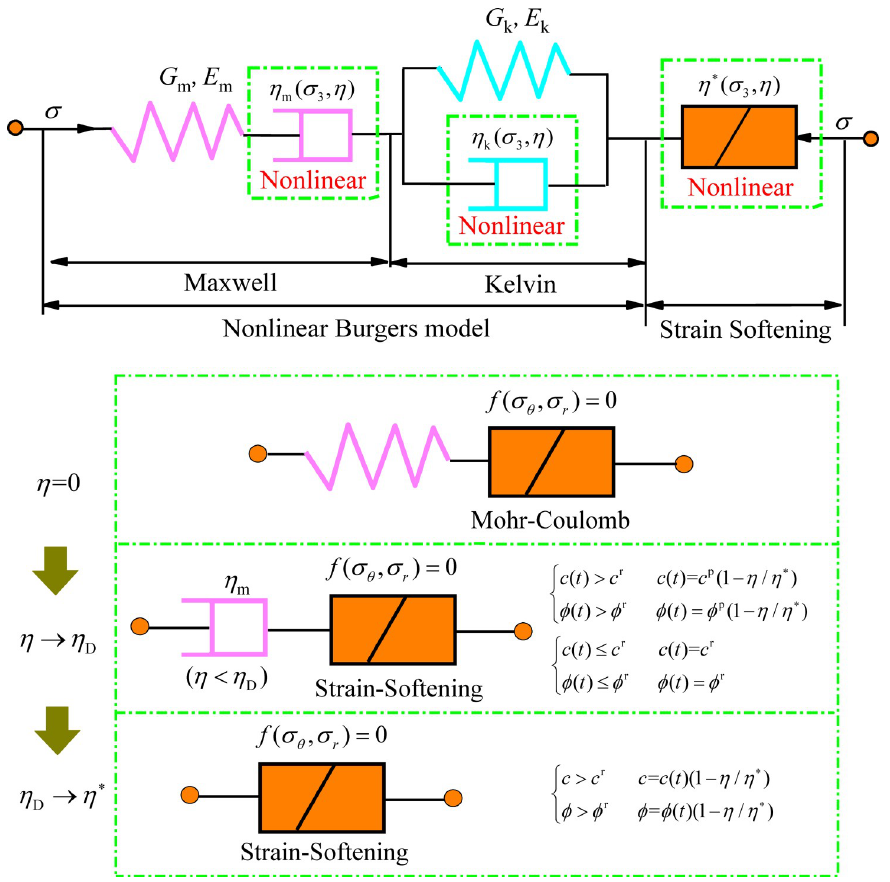
Fig 8. NBSS creep damage model of